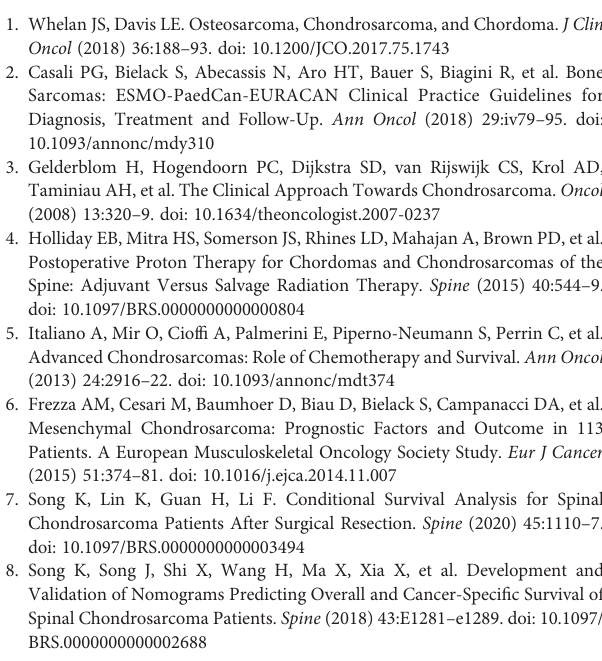
Supplementary Figure 1 | Flow chart of data collection and